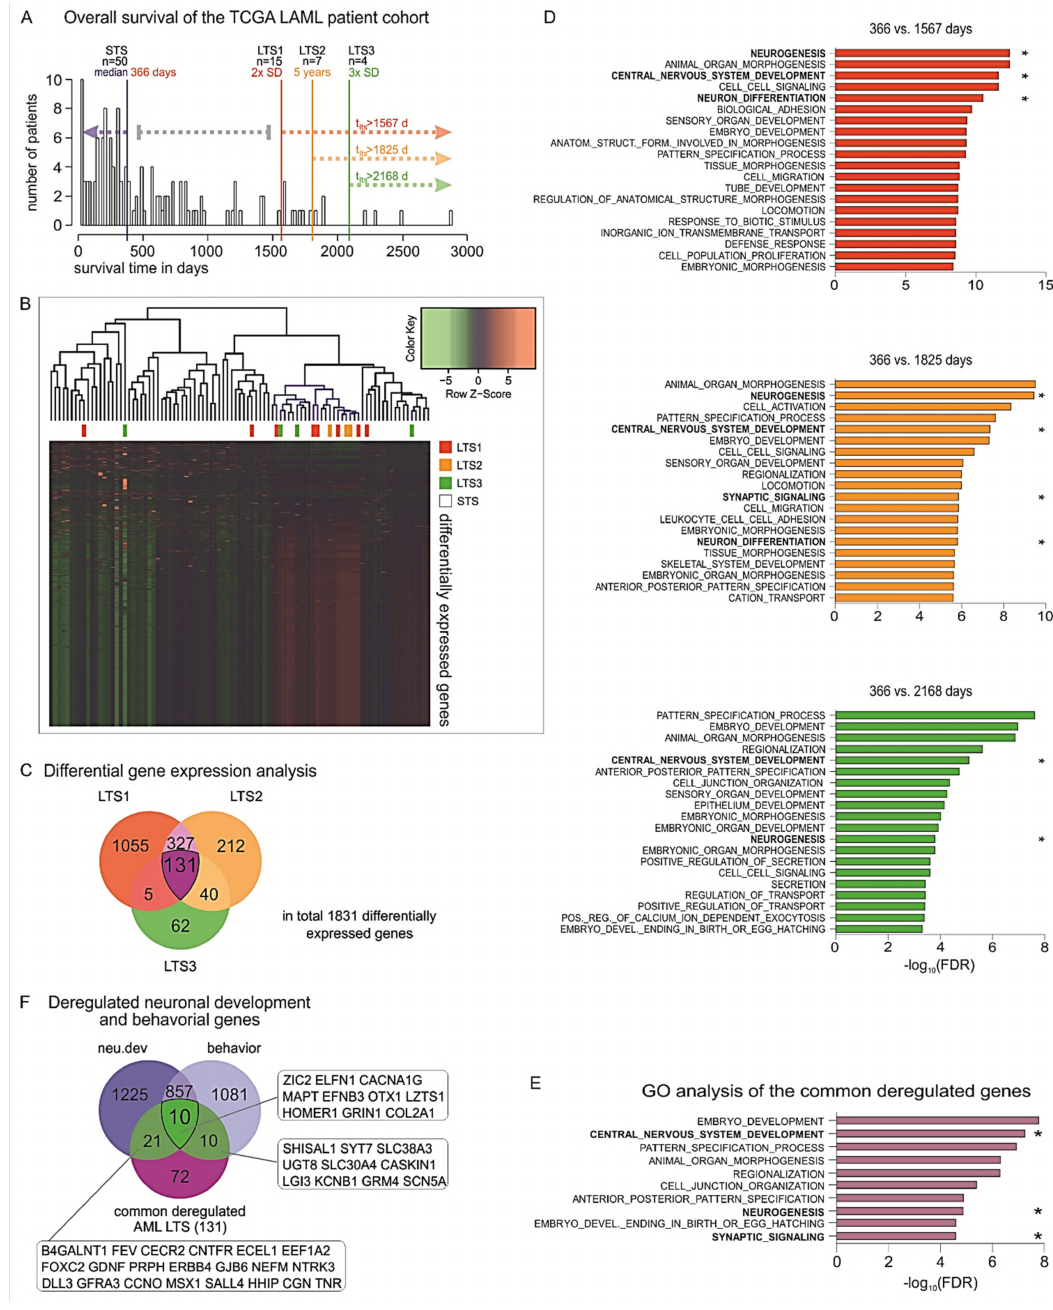
Figure 5. Identification of favorable prognostic factors based on transcriptomic profiles of LTSs. ( A ) Histogram of the overall survival (OS) of the TCGA LAML cohort with median (366 days, n = 50) and cutoffs for the three long-term survivor (LTS) groups: 2 × SD = 1567 days ( n = 15), 5-year survival = 1825 days ( n = 7), and 3 × SD = 2168 days ( n = 4). ( B ) Heatmaps of the DEGs in the three LTS subpopulations versus the STSs. ( C ) Venn diagram of the deregulated genes of all three analyses showing large overlaps between analyses and 131 genes in common. ( D ) GSEA of GO biological functions associated with the DEGs in each LTS subgroup versus the patients with OS < 366 days. ( E ) Top 10 enriched GO biological functions for the 131 genes that are commonly deregulated across all LTS subgroups, ranked by order of significance ( − log10 of FDR value). ( F ) Overlapping of the 131 genes with previously identified nervous system-related genes showed that 31.3% of these genes are indispensable for neuronal development, neurological function, or both (gene abbreviations are indicated in the respective boxes). * Nervous system-related